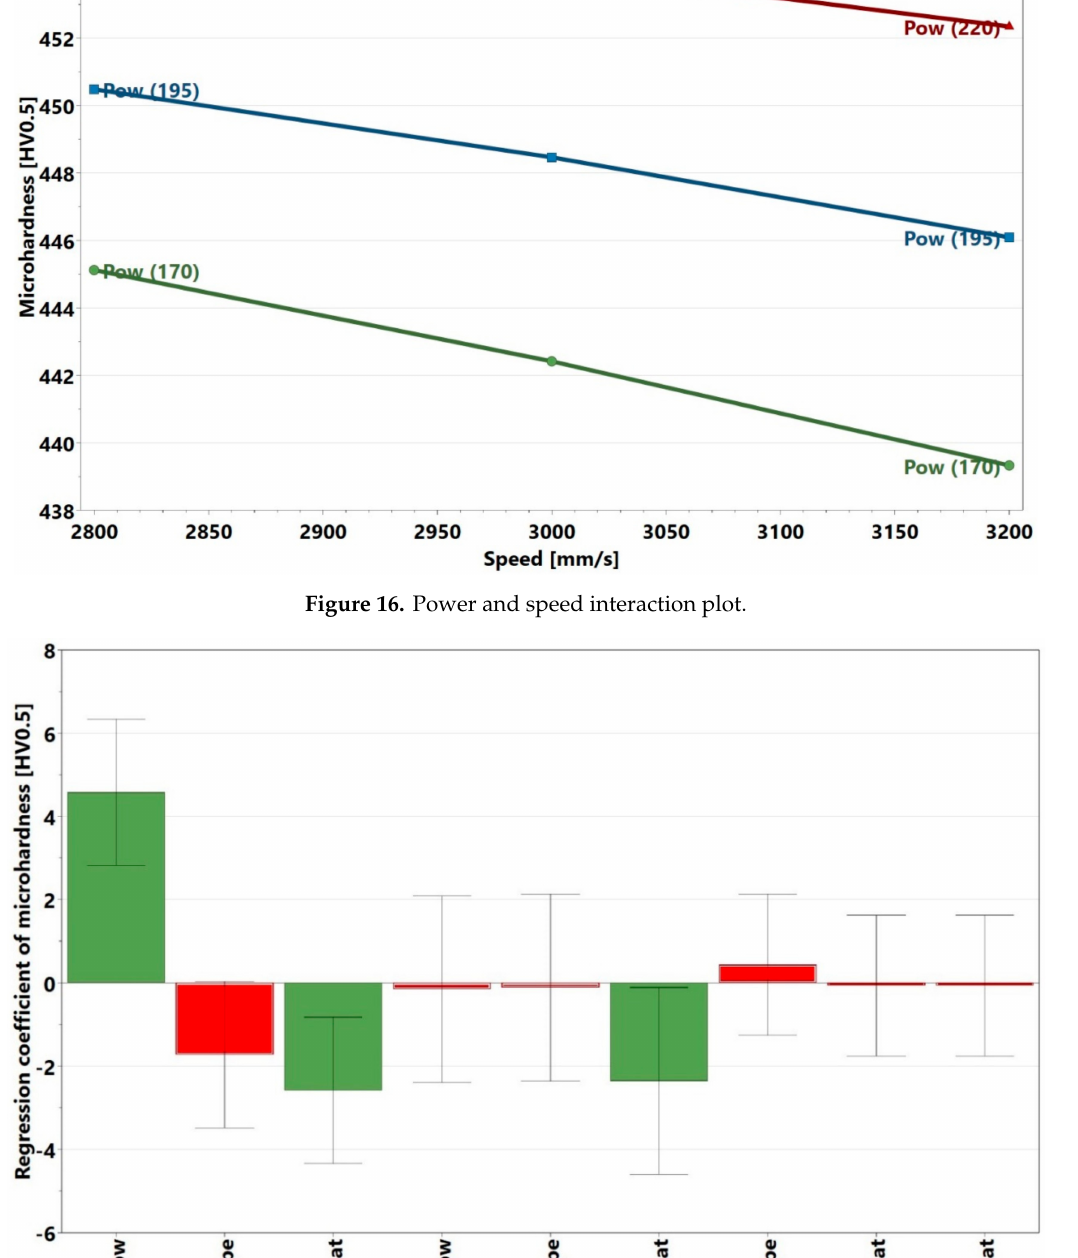
Figure 17. Regression coe ffi cients of di ff erent factors and interaction of factors a ff ecting the microhardness (the green bars indicate significant factors, while the red ones indicate non-significant